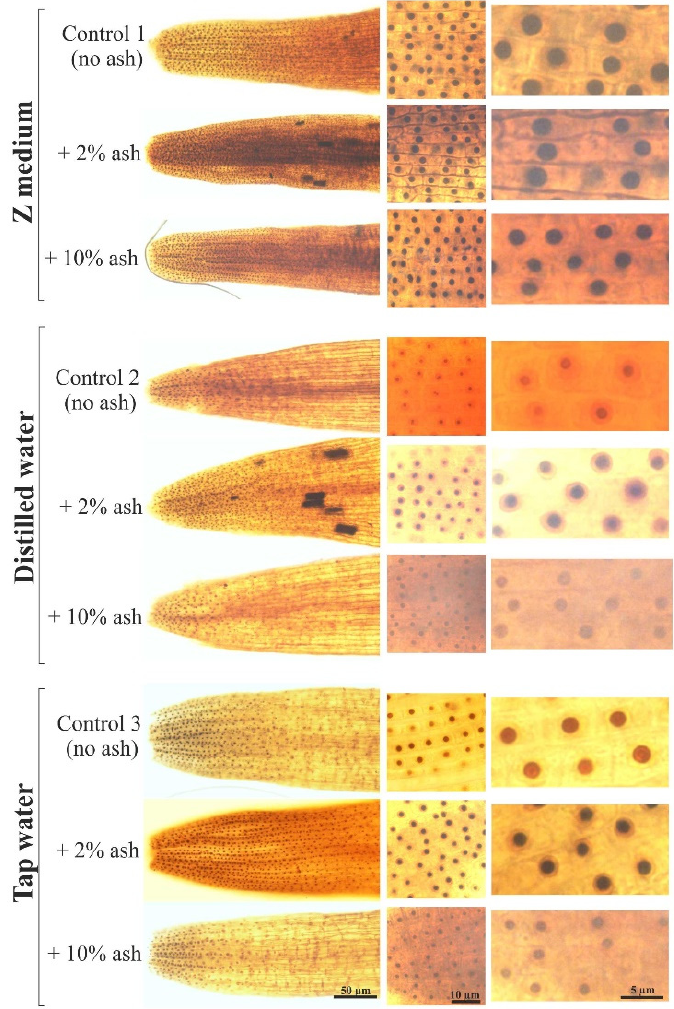
Figure 5. Root apexes (left panel) and fragments of meristematic zones with cells (middle panel) with clear nucleoli (right panel) in S. polyrrhiza plants grown in studied media.